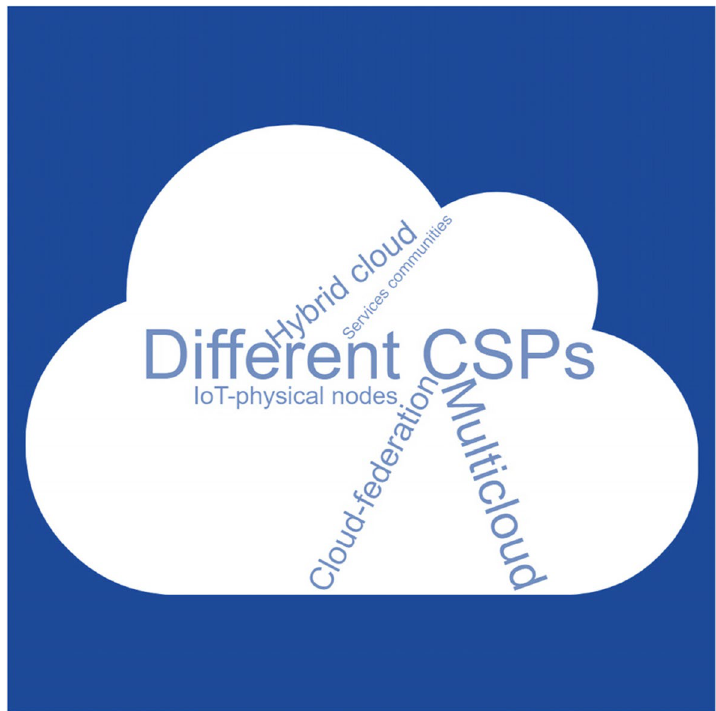
Fig. 13 Word map created with the terms collected from the definition of multi‑cloud in the primary studies. The size of the font shows the frequency of the term found in the analysis. Bigger fonts are for more frequently used terms referring to